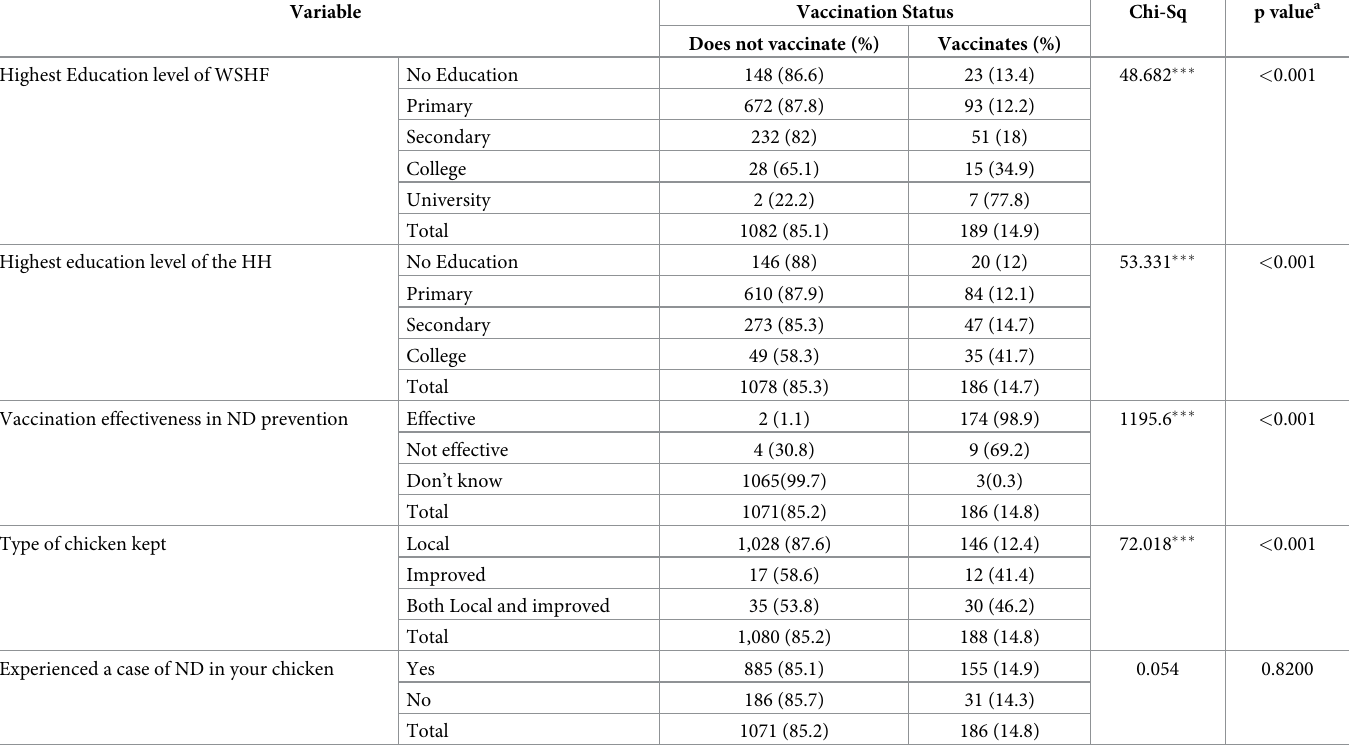
We first run exploratory t-test (presented in Table 1) and Pearson tests of association (pre- sented in Table 2) on continuous and categorical variables respectively to identify factors that had a significant association with the uptake of vaccines. Findings from independent t-tests of continuous variables and vaccine uptake reveal that there was a significant association between distance of the WSHF from vaccine vendors and vaccination uptake (t = 3.42, p < 0.001) 1269 The mean distance from vaccine vendors for farmers who vaccinated their flock was 8.18 kilo- metres compared to 10.13 kilometres from those who did not vaccinate their flock. Our find- ings also showed that the number of chicken kept by a farmers was associated with vaccine Table 2. Categorical variables associated with vaccination of